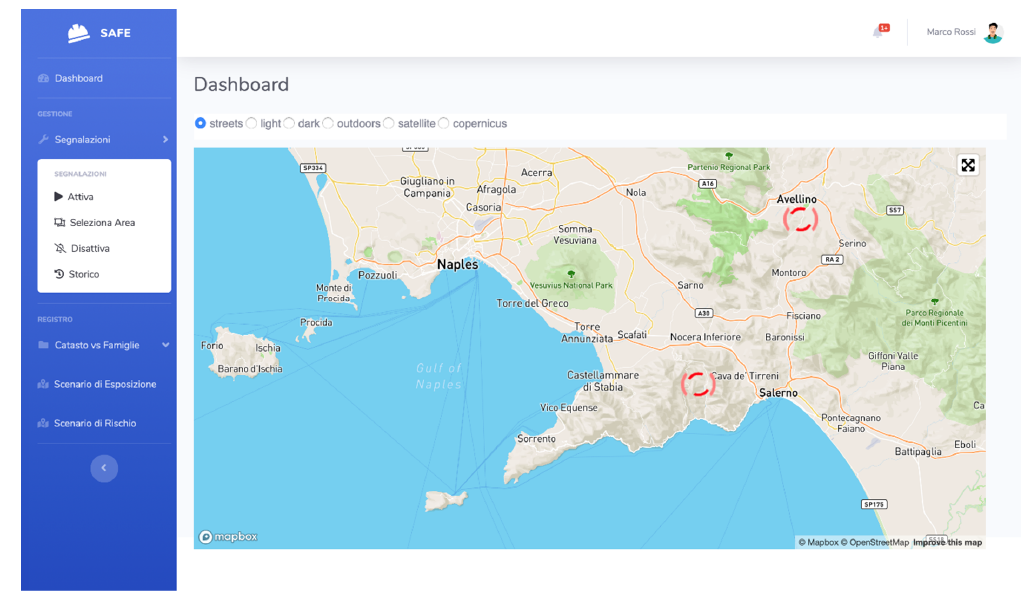
Figure 13. The SAFE visual interface with alarms.